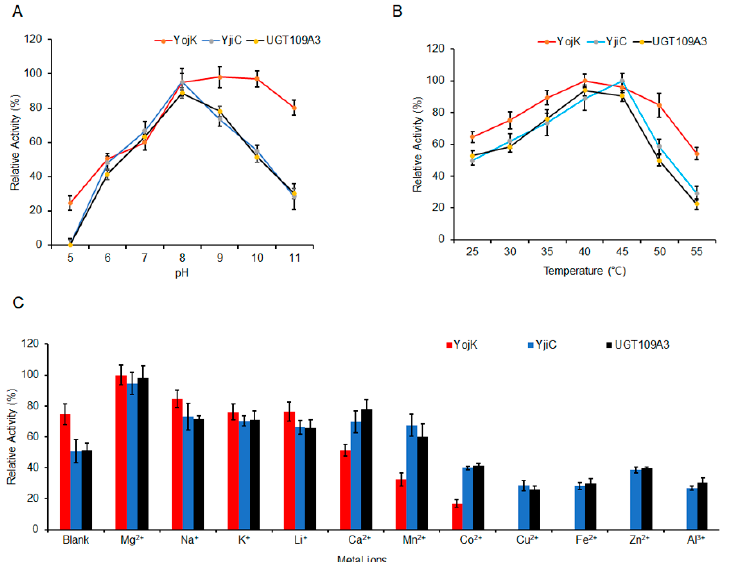
Figure 2. Effect of pH ( A ), temperature ( B ), and metal ions ( C ) on YojK, YjiC, and UGT109A3 activity for MA glycosylation. Table 2. Kinetic parameters of UGTs (Mean ± SD, n = 3).